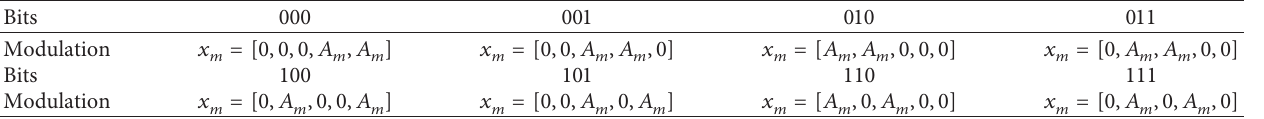
Table 1: MPPM symbol constellation.